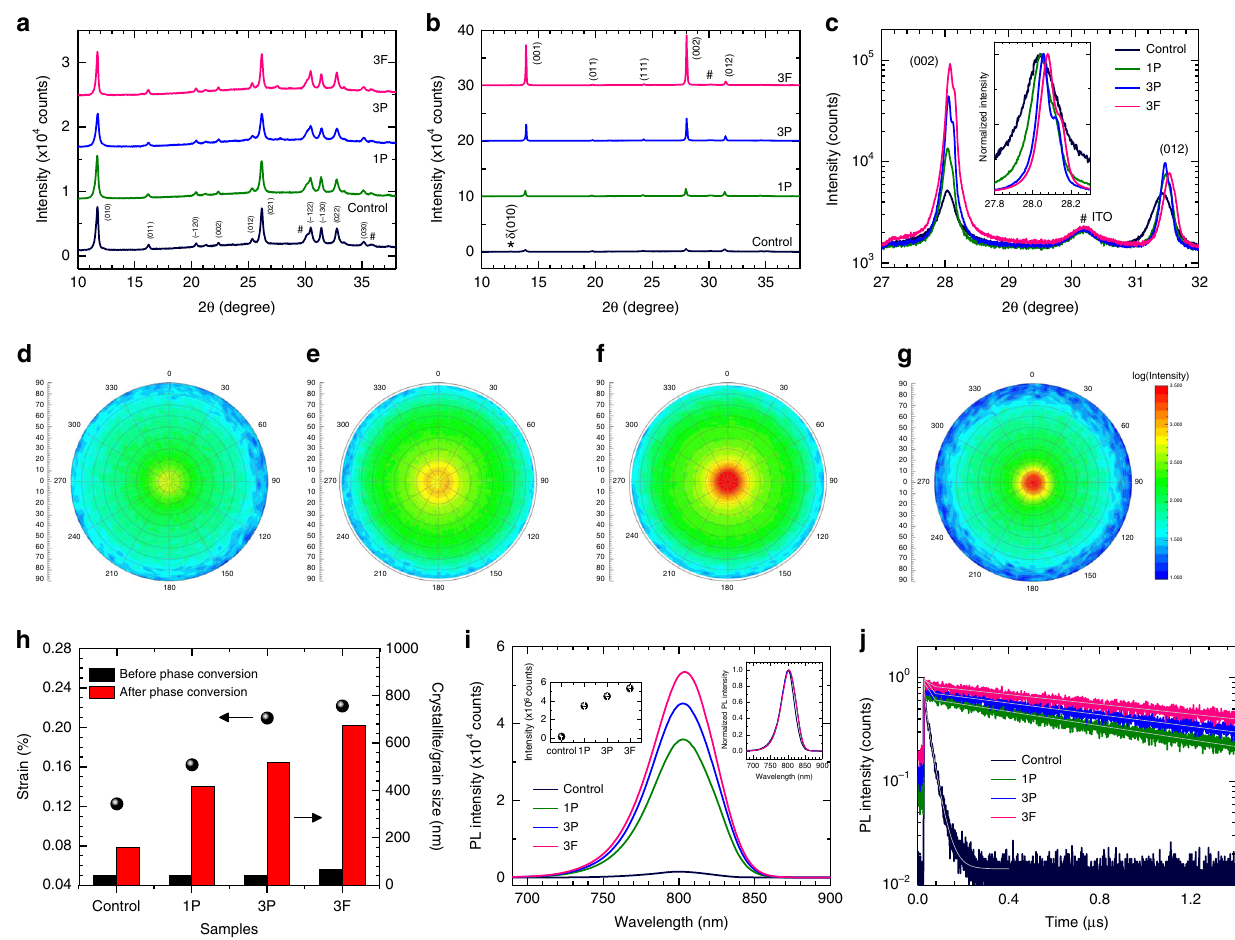
Fig. 3 Crystallographic analyses before and after the phase conversion. X-ray diffraction (XRD) patterns of the fi lms a before and b after the phase conversion process. c High-resolution X-ray diffraction (XRD) patterns of the fi lms after the phase conversion process. Inset shows the normalized (002) orientation peaks. d – g XRD pole fi gure measurements along the (001) orientation of the d control, e 1P, f 3P, and g 3F fi lms. h Composition-dependent strain before phase conversion and crystallite size of the fi lms before and after the phase conversion process. The strain was calculated using the Williamson-Hall method for the δ -FAPbI 3 fi lms. The δ -FAPbI 3 crystallite sizes were calculated by the Williamson – Hall method, while the α -FAPbI 3 crystallite sizes were extracted from the AFM images. i Steady-state photoluminescence (PL) and j time-resolved PL decay pro fi le measurements of the corresponding fi lms. Insets of i show peak intensity (left) and normalized PL spectra